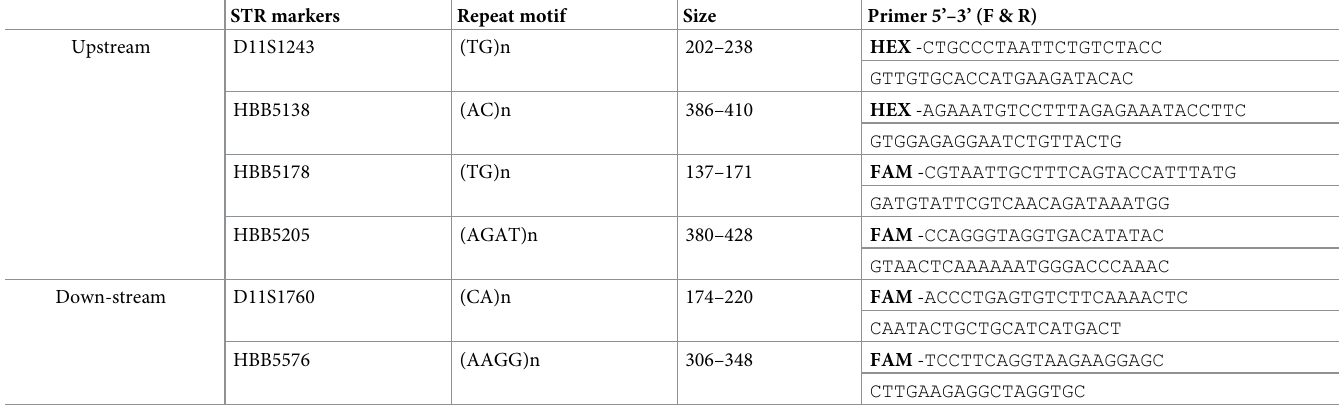
Table 1. STR markers